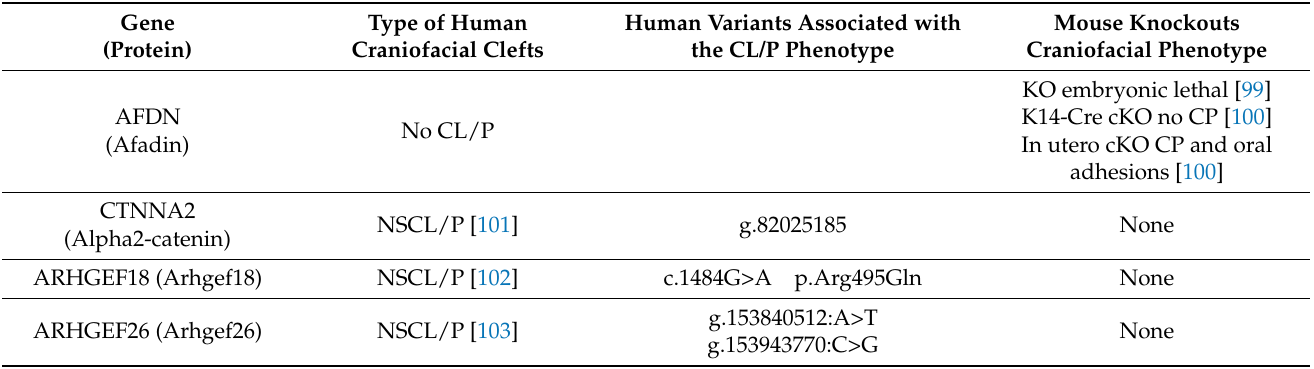
Figure 6. Summary of cell–cell adhesion and the cytoskeletal proteins involved in human and mouse cleft lip with or without palate . Adhesion molecules discussed in this review were distributed on the basis of whether they played a role in human cleft lip with or without palate (CL/P), mouse CL/P, both, or had no identified role in craniofacial morphogenesis. Table 2. Summary comparison of cell adhesion molecules, cleft lip with or without palate in human, and murine knockout